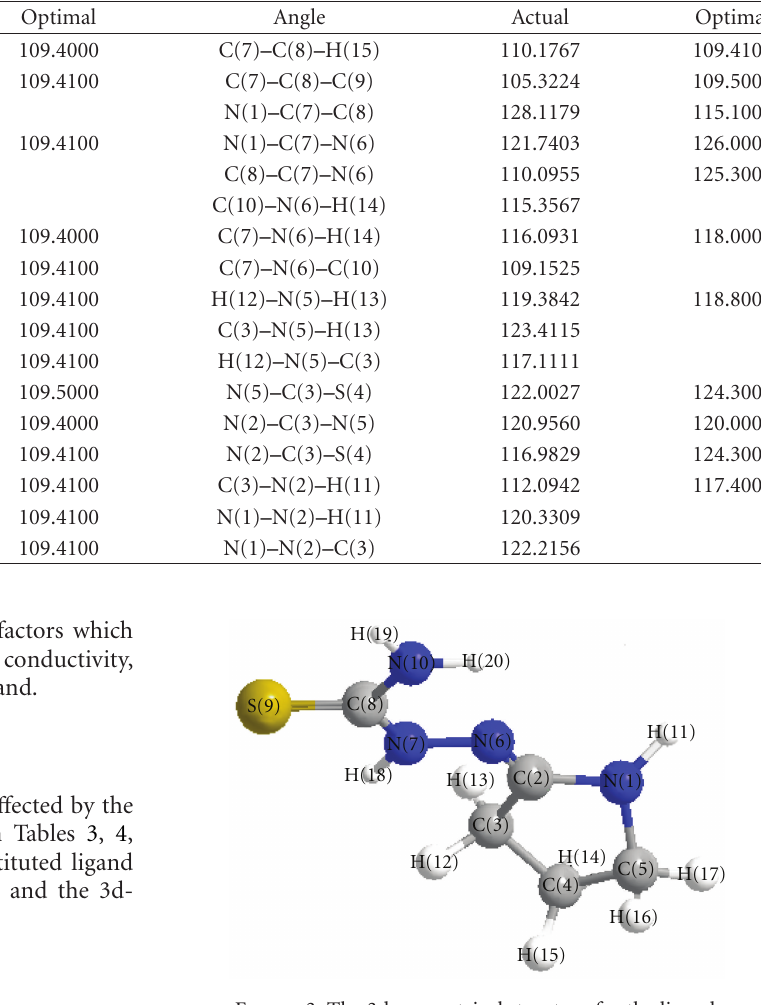
of Staphylococcus aurous and Klebsiella , whereas other com- plexes have less activity against other tested bacteria. The theoretical data obtained show that the heat of formation is 52.61737 kcal/mole, and the highest atomic charge (Table 5) in ligand molecule is at [S4 − 0.696] and the next charge value is at [N1 − 0.431]. These data show clearly that these atoms are the most reactive toward the bonding with the